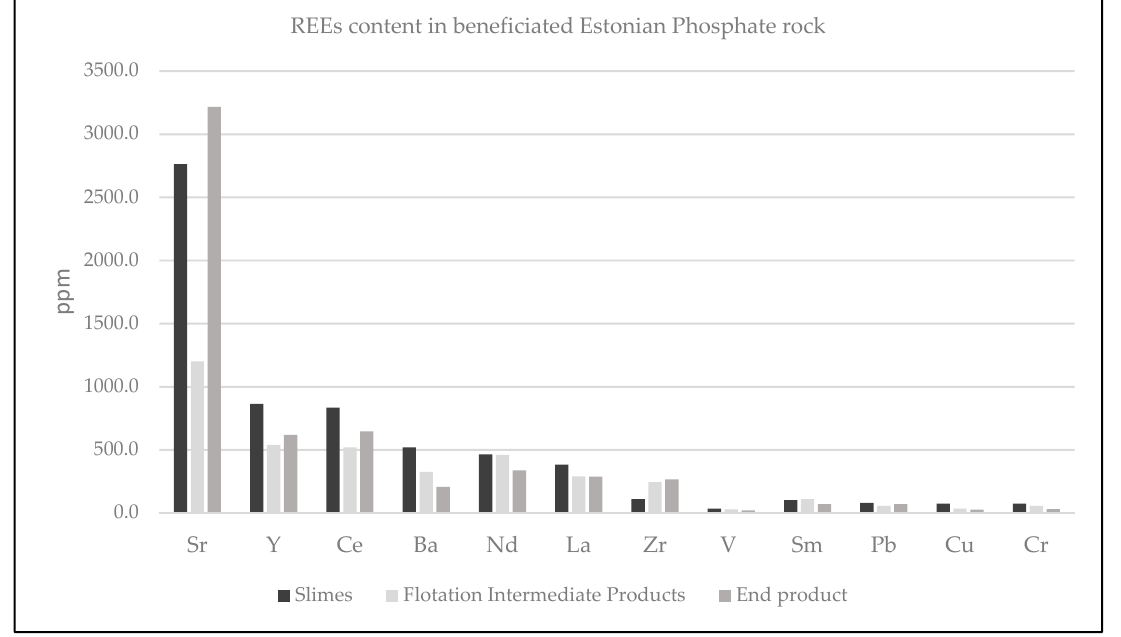
Figure 7. REEs content in beneficiated Estonian Phosphate rock.